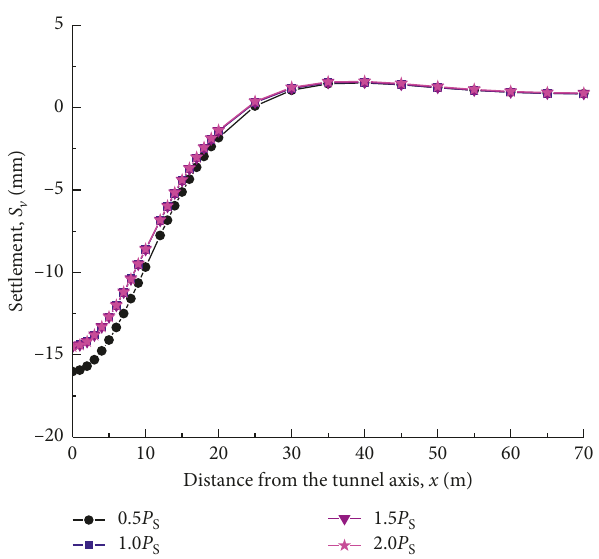
Figure 21: Transverse surface settlement profiles for four different slurry